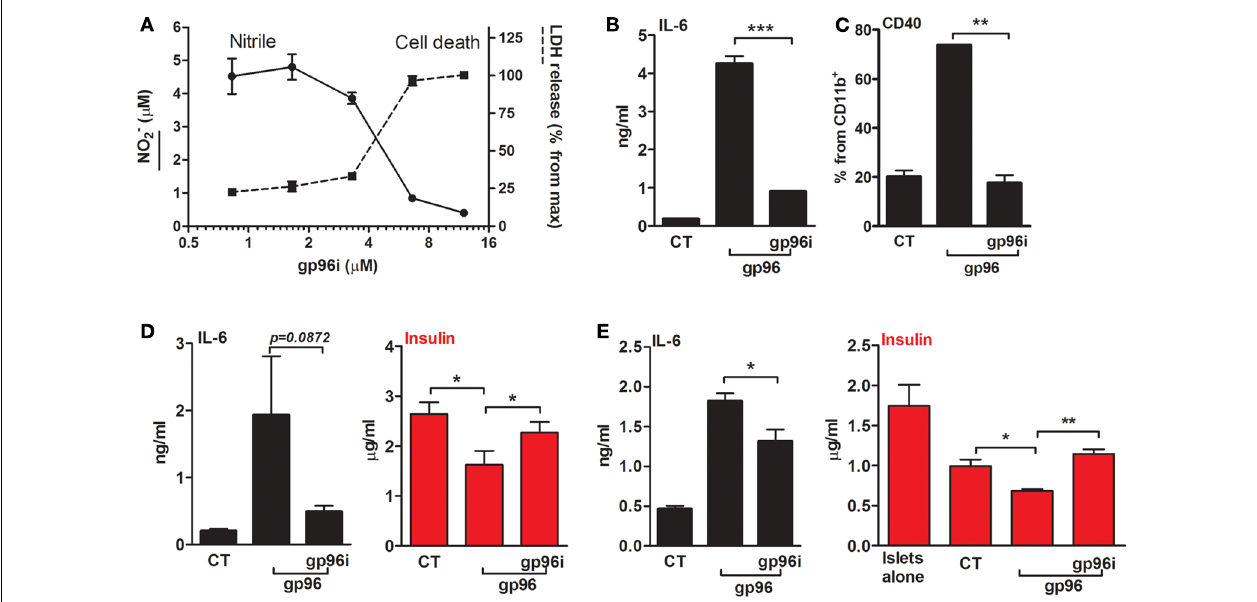
FIGURE 5 |An inhibitor of gp96 (gp96i) modulates inflammatory responses in macrophages and islet cultures . (A) Calibration assay. Peritoneal macrophages (4 × 10 5 per well in quadruplicates) were incubated in the presence of recombinant gp96 (50pM) and gp96i (0–16 µ M) for 24h. Nitrile release into supernatants was evaluated by Griess assay. Cell death was evaluated by LDH release into the supernatants, normalized to the output of maximal gp96i concentration. (B) Release of inflammatory mediators. Peritoneal macrophages (4 × 10 5 per well in quadruplicates) were pretreated with gp96i (3.3 µ M) and then incubated with recombinant gp96 (50pM) for 48h. IL-6 levels in supernatants were evaluated by ELISA. (C) Activation markers. Peritoneal macrophages (2 × 10 6 per well in quadruplicates) were pretreated with gp96i (3.3 µ M) and then incubated